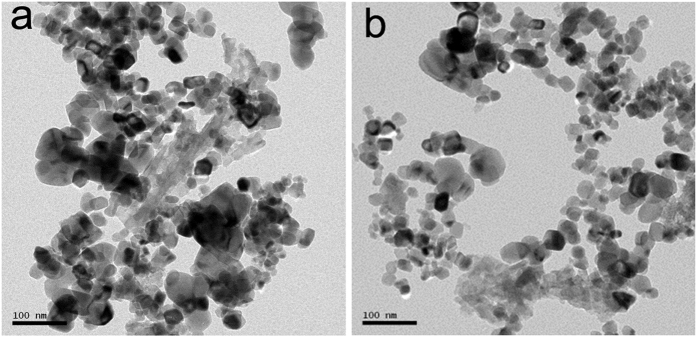
TEM images of catalysts: (a) CuO/SiO2; (b) CuO/Al2O3-SiO2.